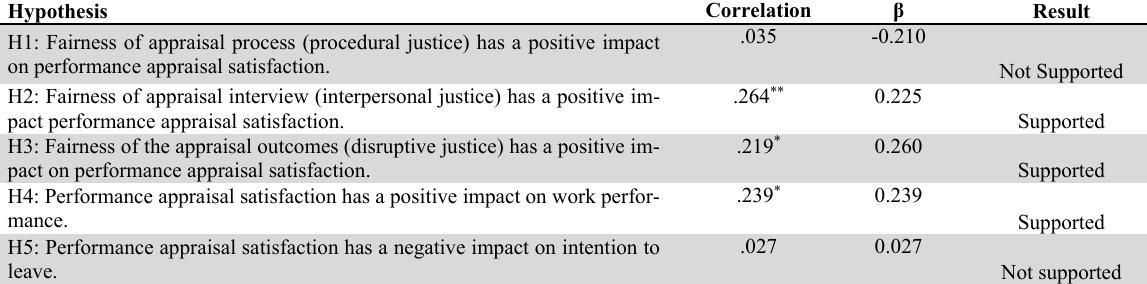
The summary of the results Hypothesis